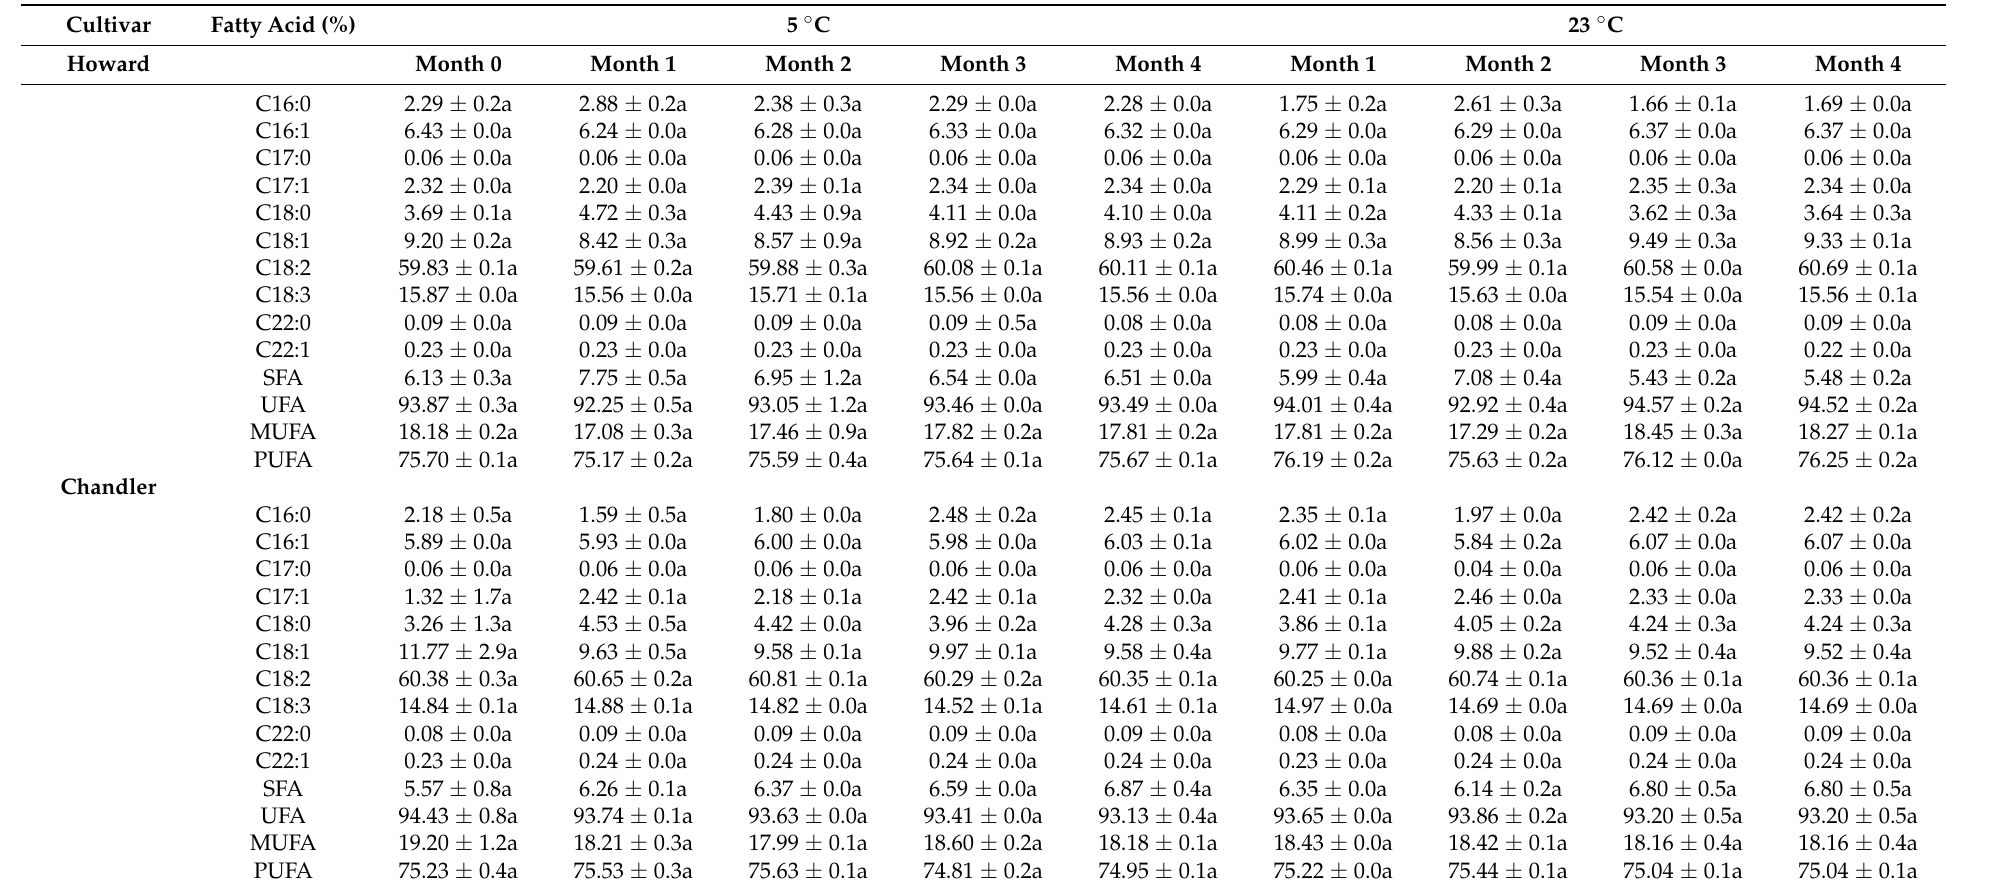
Table 3. Changes in oil fatty acids profile during